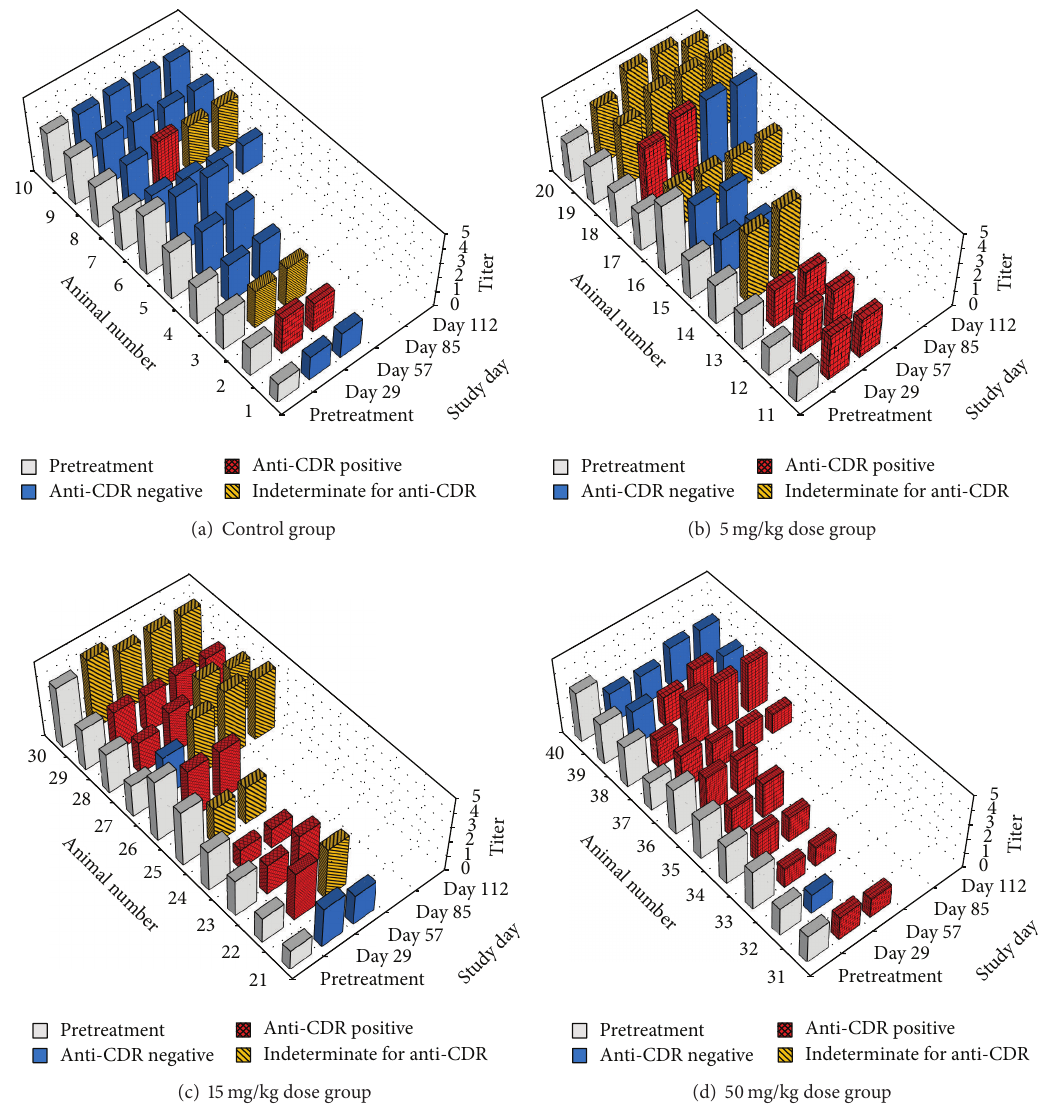
Figure 5: Response-time plots of ATA titer to the whole F(ab 󸀠 ) 2 molecule and anti-CDR ATA positivity status by dose group. Solid light gray bar: pretreatment titer (average of two samples). Solid blue bar: posttreatment titer for anti-CDR negative sample. Horizontal hatched red: posttreatment titer for anti-CDR positive sample. Diagonal hatched yellow bar: posttreatment titer for anti-CDR indeterminate